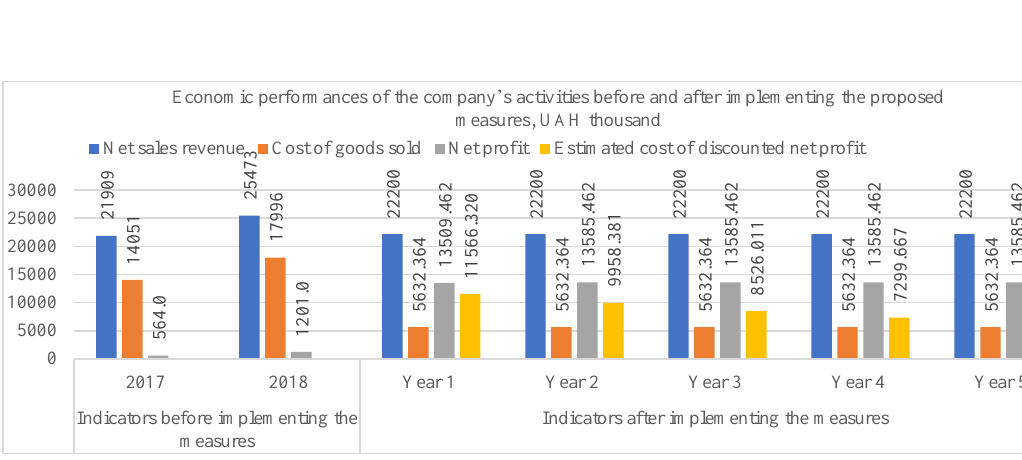
Figure 1. Economic performances of the company’s activities before and after implementing the proposed measures, UAH thousand (Net sales revenue, Cost of goods sold, Net profit and Estimated cost of discounted net profit).